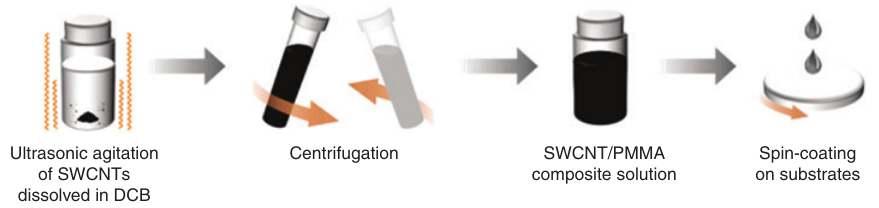
Figure 3: Fabrication procedure of CNT SA for the bulk lasers.